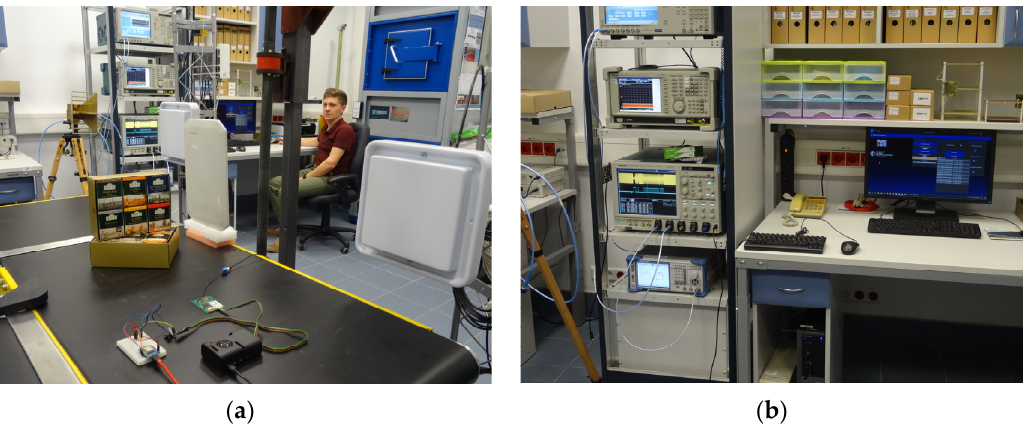
Figure 6. Laboratory stand: ( a ) Operational space of RFID system; ( b ) Measurement center.